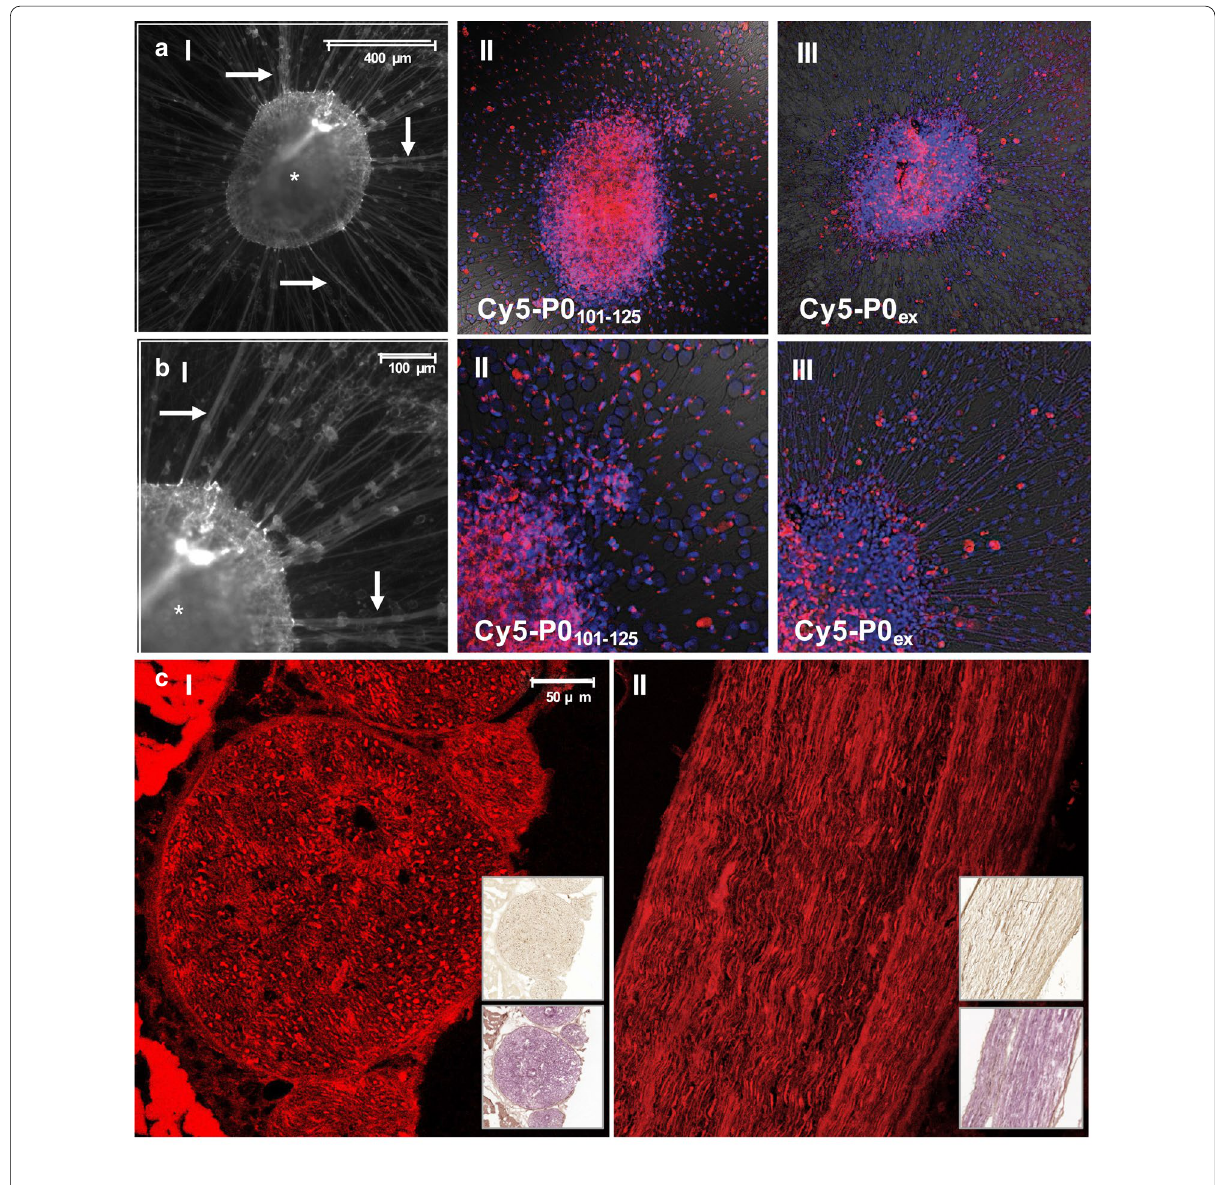
Fig. 3 Staining of 3D DRG explant cultures with Cy5-P0 101–125 and Cy5-P0 101–125 fluorescence immunohistochemistry of a murine nervus ischiadicus . A brightfield image of a 3D DRG explant (*) with axonal outgrowths (white arrow) after staining with (II) Cy5-P0 101–125 or (III) Cy5-P0 ex . B Zoom-in with focus on the axonal outgrowths and fluorescence confocal imaging of DRG explants after staining with (II) Cy5-P0 101–125 or (III) Cy5-P0 ex . C Fluorescence immunohistochemistry of the nervus ischiadicus of THY1-YFP mice in (I) transverse orientation and (II) sagittal orientation after staining with Cy5-P0 101–125. The top insert shows standard anti-body-based standard immunohistochemistry and the bottom insert H&E staining of a concurrent/adjacent tissue